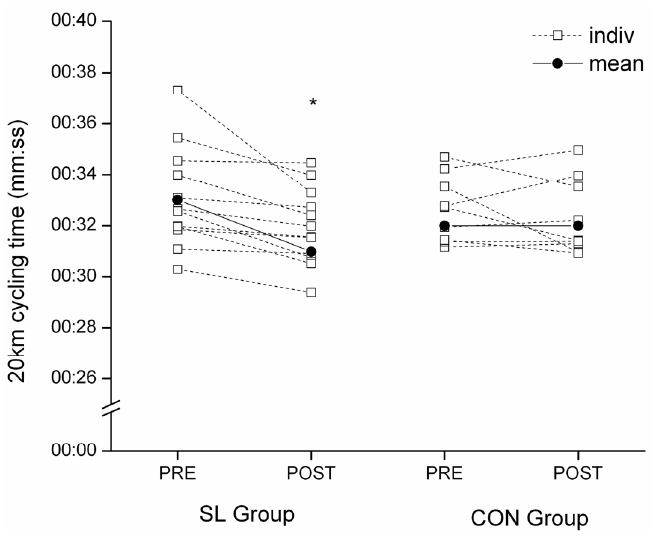
Figure 2. Individual 20 km cycling time-trial performance for SL and CON groups in PRE and POST tests. * Significantly different from PRE values, p < 0.05.